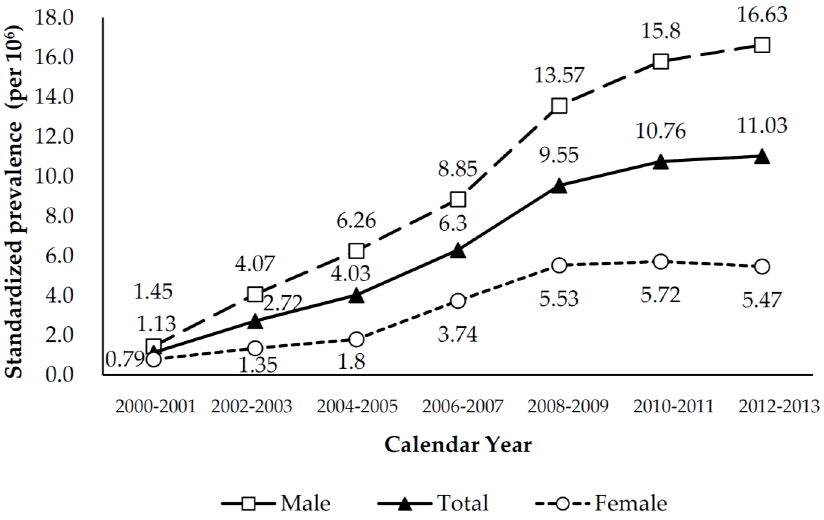
Figure 1. Overall (sex ‐ age ‐ standardized) and sex ‐ specific (age ‐ standardized) biennial prevalence of liver transplantation in Taiwan, 2000–2013.